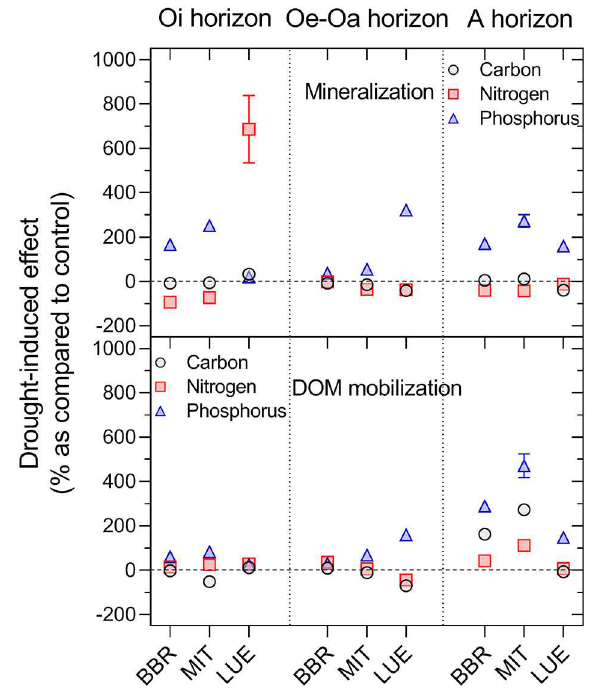
FIGURE 6 | Effects of the drying-rewetting on the net mineralization of C, N, and P (upper panel) and mobilization of C, N, and P in dissolved organic matter (lower panel). Here, only data from the first 4 leaching cycles after the second dry spell are shown. Means and standard errors of four replicates.